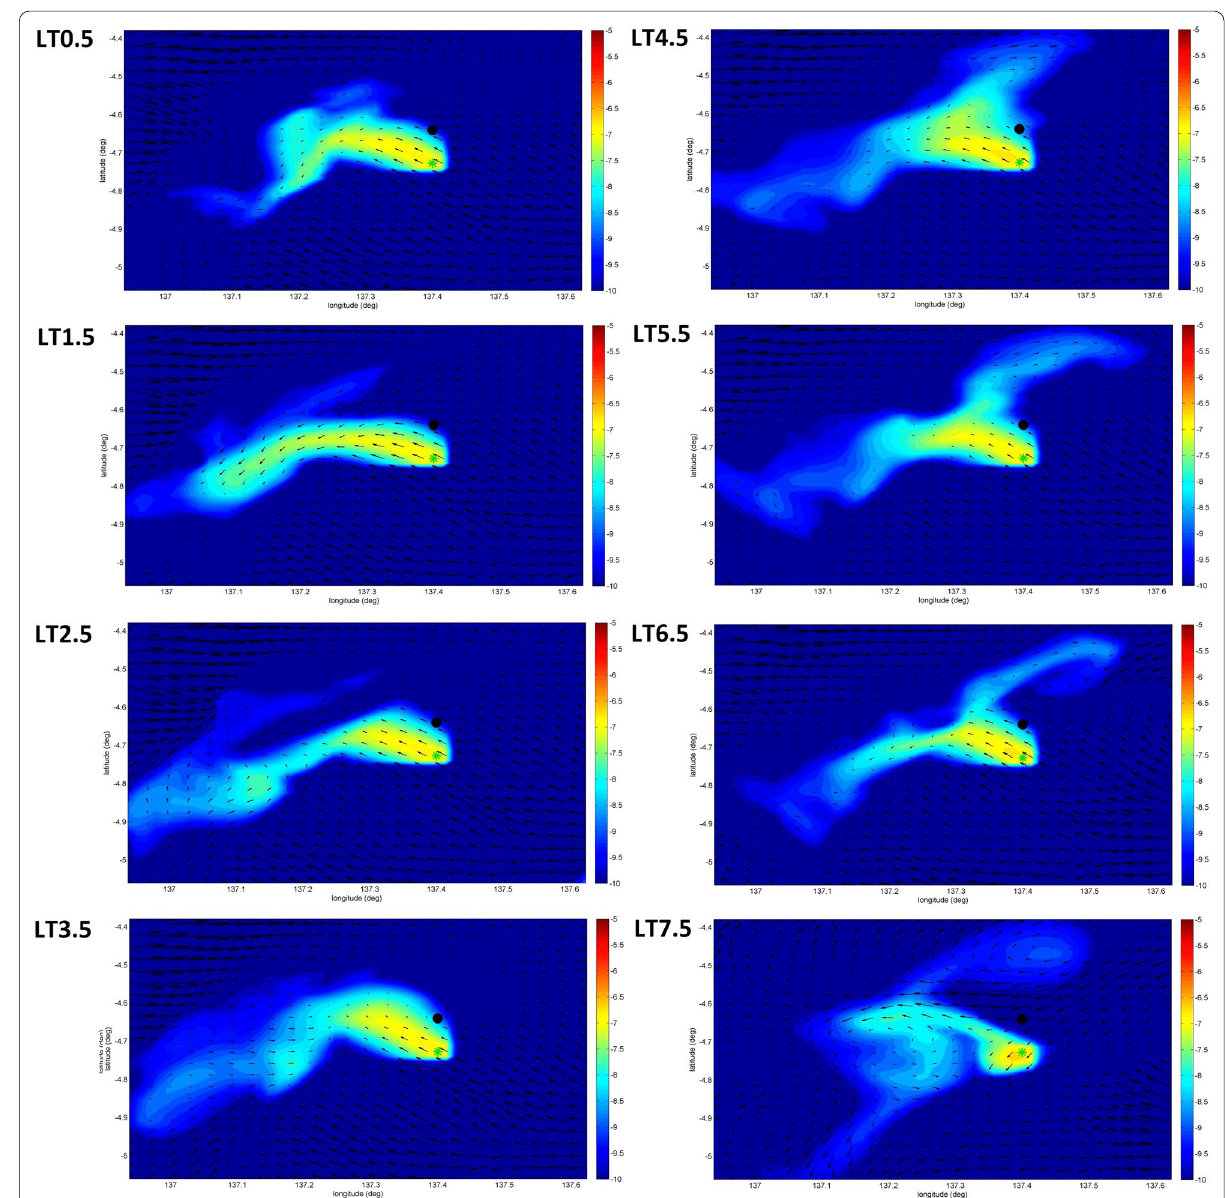
Fig. 9 Surface methane distribution, in logarithmic scale, in the vicinity of the MSL in several time instants covering a methane spike presented in Fig. 8 and produced by a source location centered at 4.7 deg of latitude, 137.4 deg of longitude, in time intervals of 1 h starting on local true solar time (LTST) 0.5 h. MSL’s general location is also indicated by a =